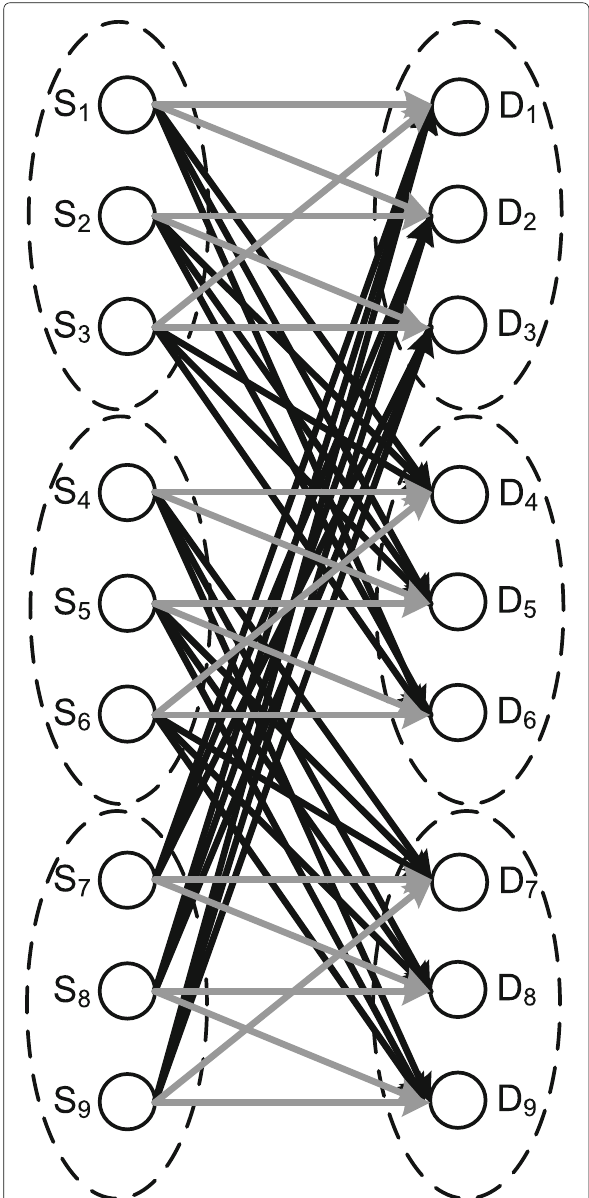
Fig. 16 A 2-nested folded-chain